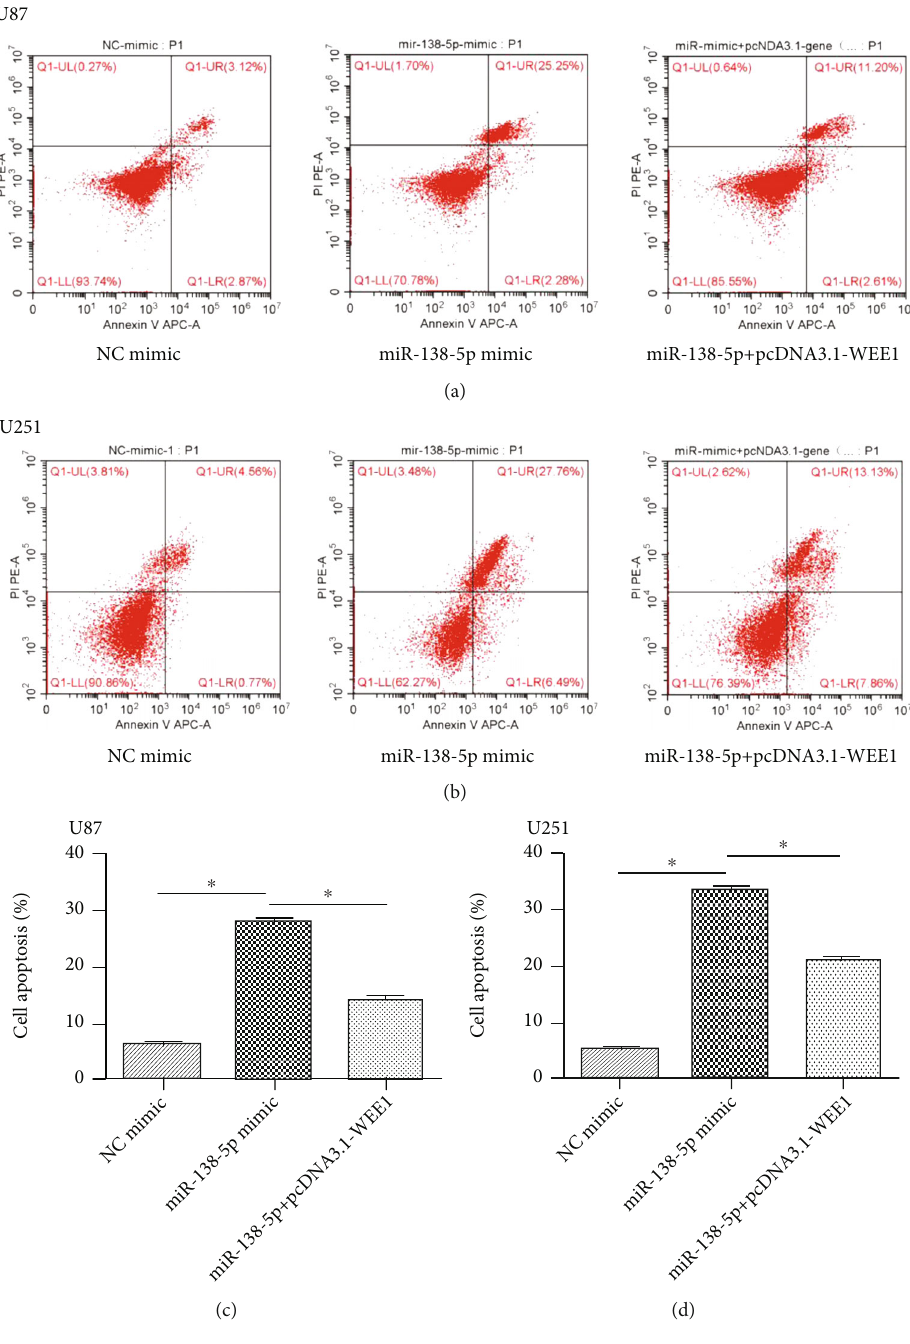
Figure 9: WEE1 expression reduced miR-138-5p-induced apoptosis in U87 and U251 cells. (a, b) The mortality of U87 and U251 cells in each group was determined by fl ow cytometry. (c, d) Compared with NC mimic, miR-138-5p mimic promoted apoptosis of U87 and U251 cells. And in U87 and U251 cells, the apoptosis rate of transfected miR-mimic+pcDNA3.1-WEE1 was lower than that of transfected miR- 138-5p mimic alone. Each experiment was repeated at least three times. ∗ P < 0 : 05